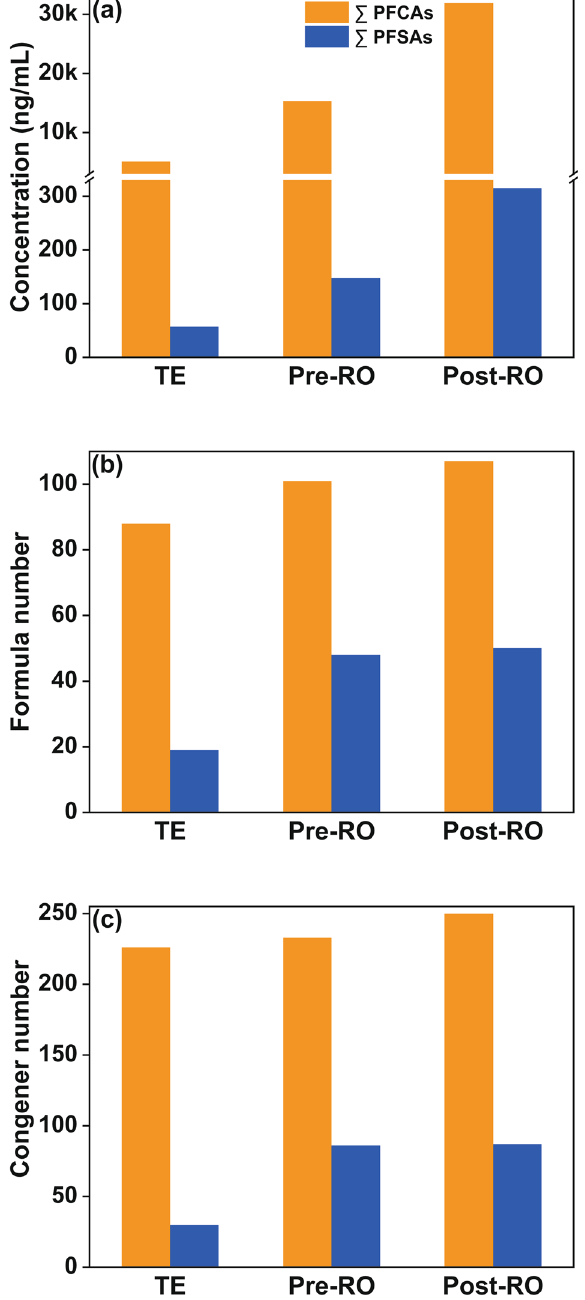
Fig. 3 Distributions of the Σ PFCAs and Σ PFSAs identi fi ed in the wastewater